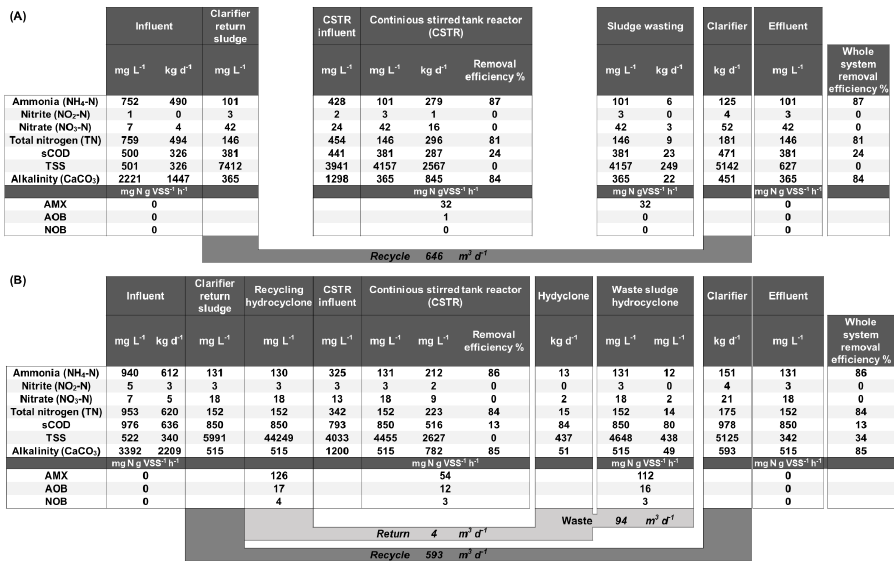
Figure 4. Mass-balance of the S-CSTR and anaerobic ammonia oxidizing bacteria (AMX), ammonia oxidizing bacteria (AOB), and nitrite oxidizing bacteria (NOB) activities in the sludge lines and main reactor for Period 2 ( A ), operation without solids retention time control ( A ) and for Period 4, operation with solid retention time control ( B ).